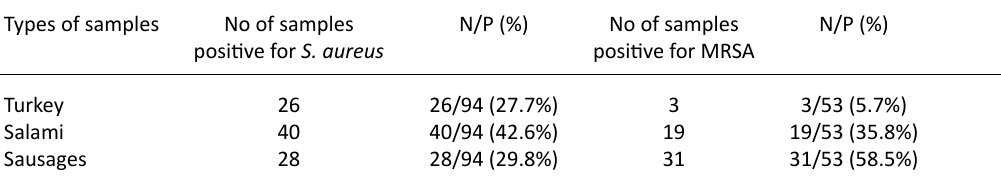
table 1. The prevalence of S. aureus and MRSA among the examined samples in Riyadh, Saudi Arabia Types of